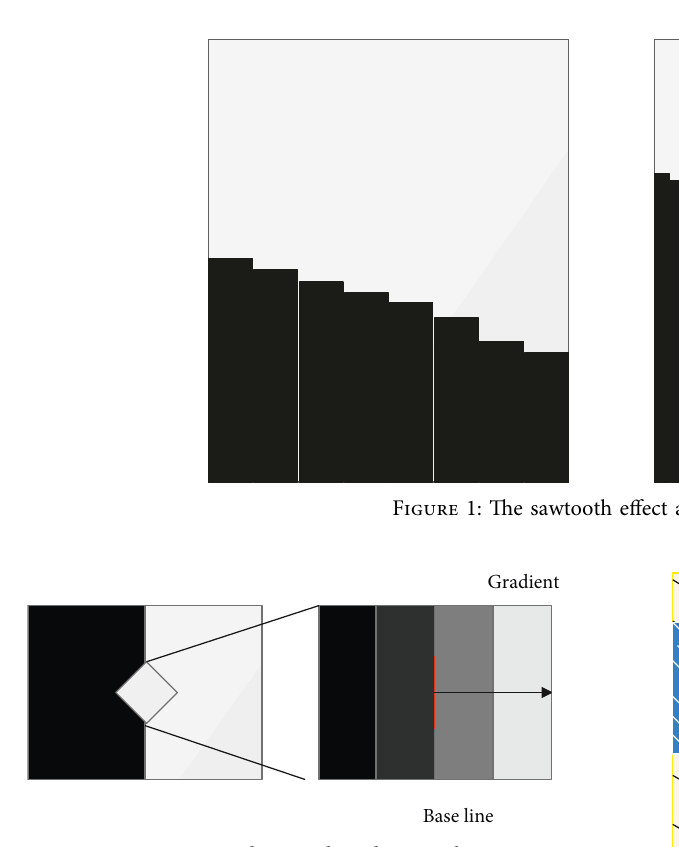
(1) The algorithm reduces the image to 80% of the original through Gaussian downsampling (both the length and width are reduced to 80% of the original, and the total pixels become 64% of the original). The purpose of this is to reduce or eliminate the aliasing effect that often appears in the image, as shown in Figure 1: (2) The algorithm calculates the gradient amplitude and gradient angle of each pixel in the image, as shown in Figure 2. The algorithm uses a 2 × 2 template to calculate the gradient and gradient angle. The smallest possible template is used to reduce the dependence between pixels in the gradient calcula- tion process while maintaining a certain degree of independence. We assume that i ( x , y ) is the image gray value at pixel ( x , y ); the gradient calculation